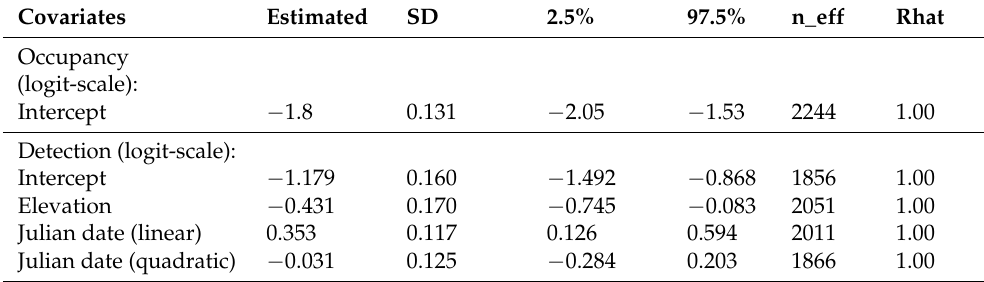
Table A5. Output summary from the best occupancy model ( ψ (intercept); ρ (intercept + elevation